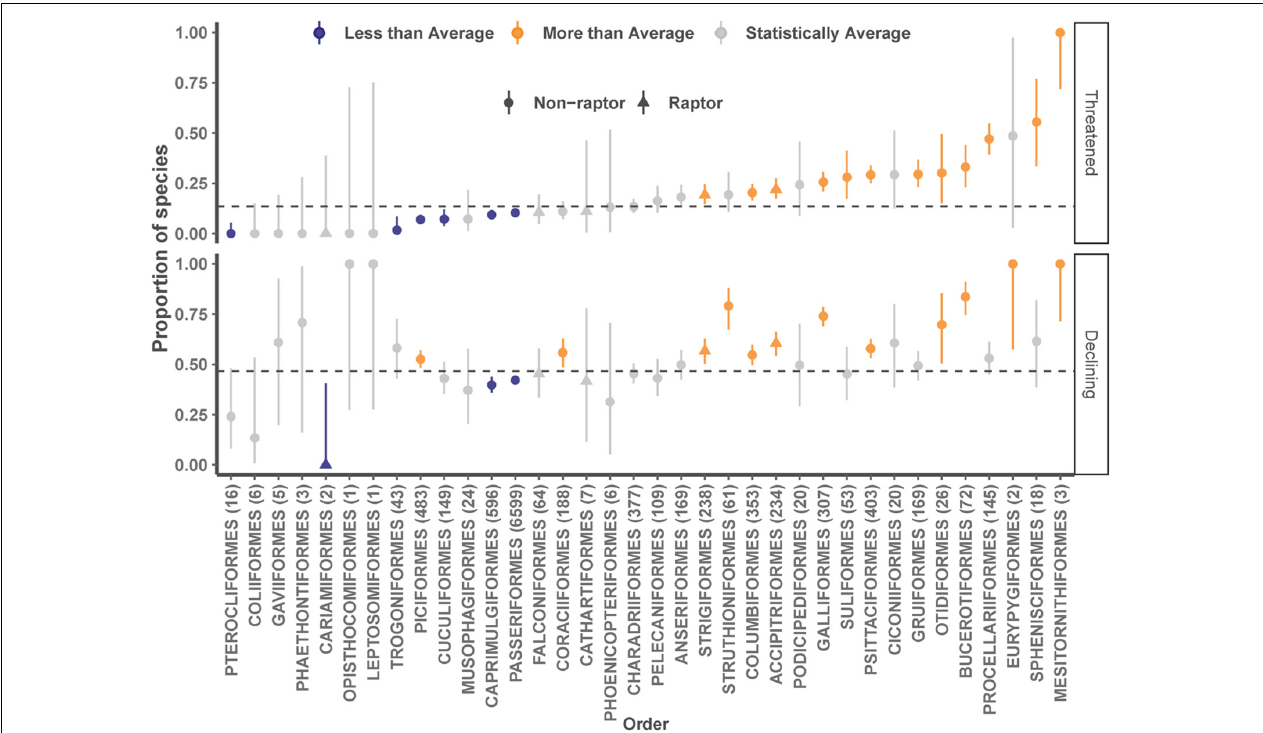
FIGURE 2 | Median (points) and 95% CRI (lines) of proportions of threatened and declining species per bird order. Horizontal dashed lines represent the Class-wide proportion (i.e., Average). Orders are more than average (orange) if the 95% CRI of the difference between the order’s proportion and the average is negative, and less than average (blue) if that value is positive. Moving from left to right, orders are ranked by median proportion of threatened species. The parenthetical numbers in the x-axis labels are the number of species per order.